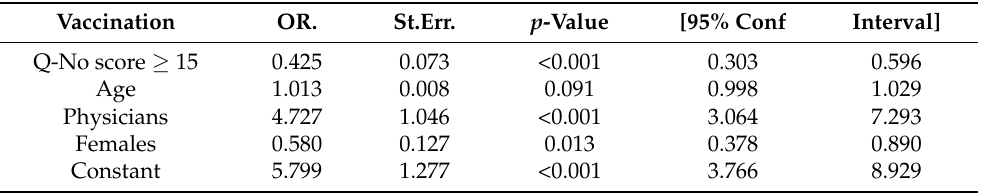
Table 3. Multivariate logistic regression analysis for vaccine acceptance by Q-No score, gender, age, and occupation.